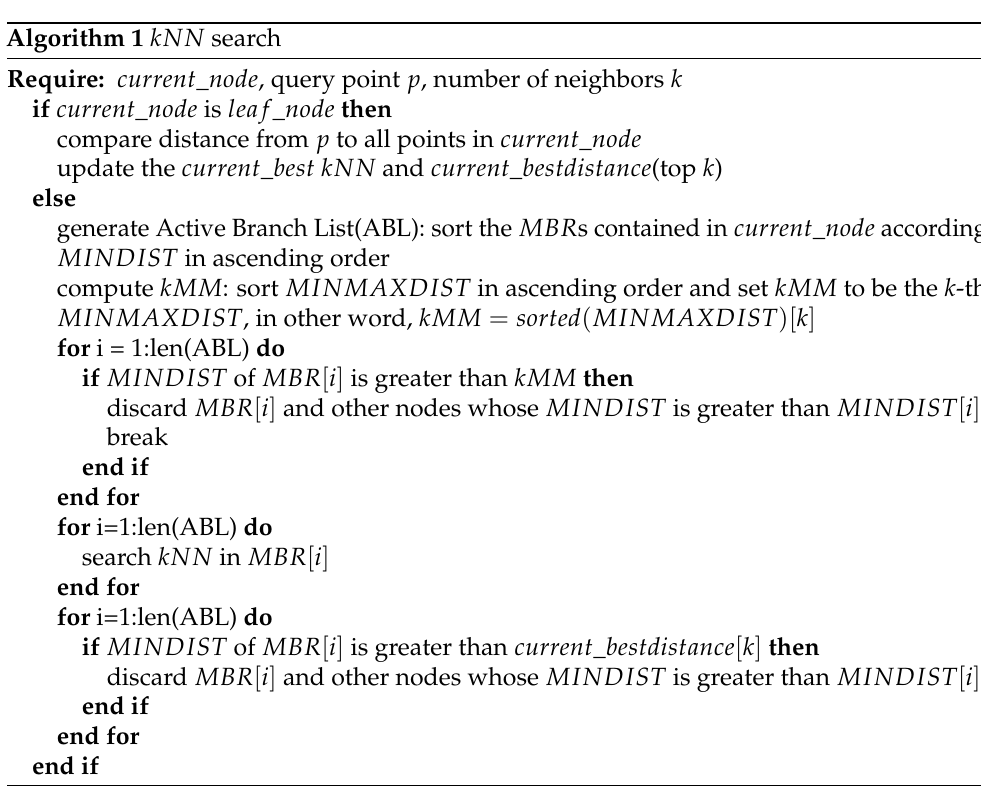
Algorithm 1 kNN